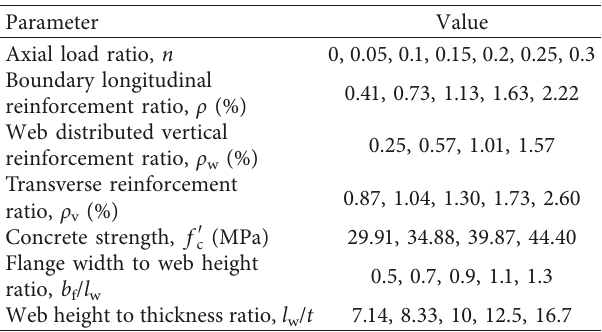
Figure 3: Experimental results compared with analytical predictions. (a) Specimen TW-1. (b) Specimen TW-3. (c) Specimen TW-4. Table 1: Summary of the parameters